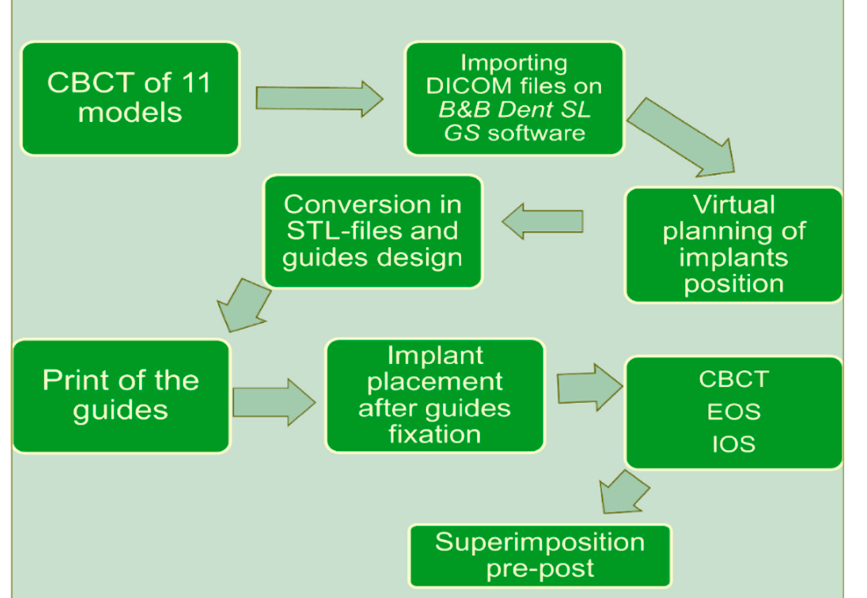
Figure 2. The scheme of the flow-chart.